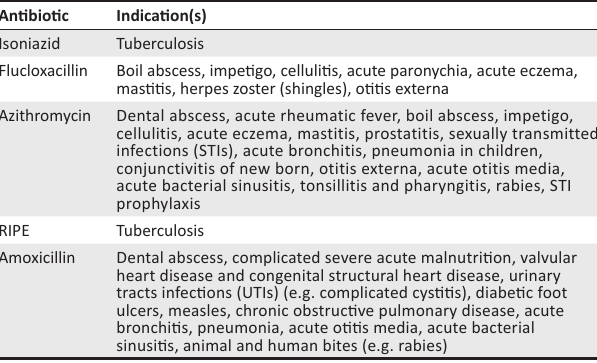
TABLE 4: Antibiotic route of administration between 01 April 2015 and 31 March 2018.